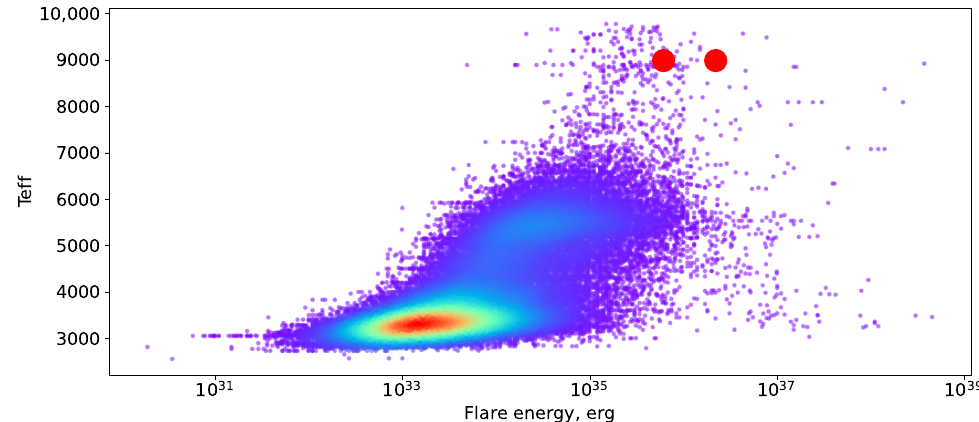
Figure 10. Energies of the flares of HD36030 (red circles) in comparison with the ones detected by Yang et al. [29], as a function of the effective temperatures of the stars. The temperatures are originating from Gaia DR2 [63] and are underestimated for the hottest objects. The colors of the dots represent the density of